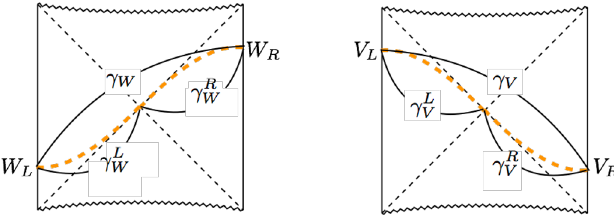
) are represented schematically , γ L , γ R , γ L W W V V